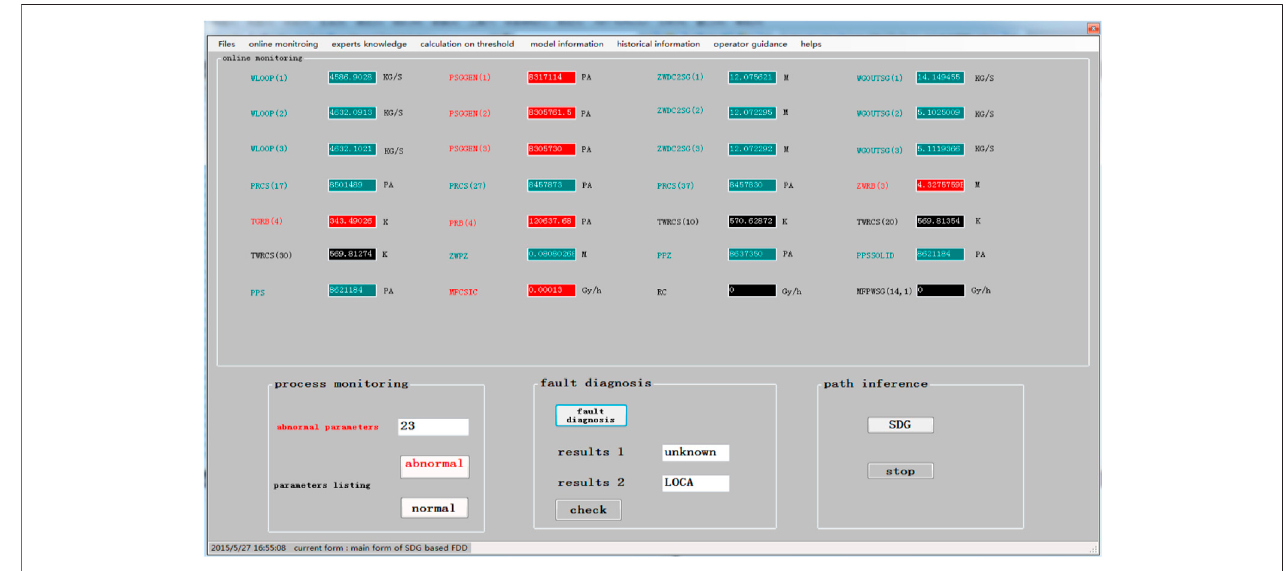
FIGURE 10 | Interface of FDD when LOCA occurred.